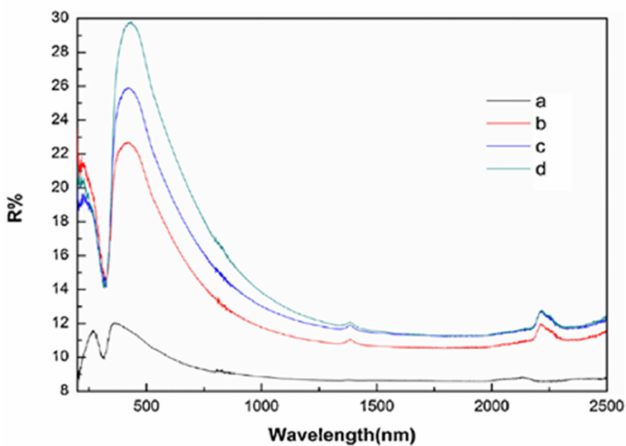
Figure 5. Reflectivity spectra of LST coatings: (a) LST-1, (b) LST-2, (c) LST-3, and (d) LST-4 (samples are listed from high to low powers), reproduced from [37], with permission of Elsevier